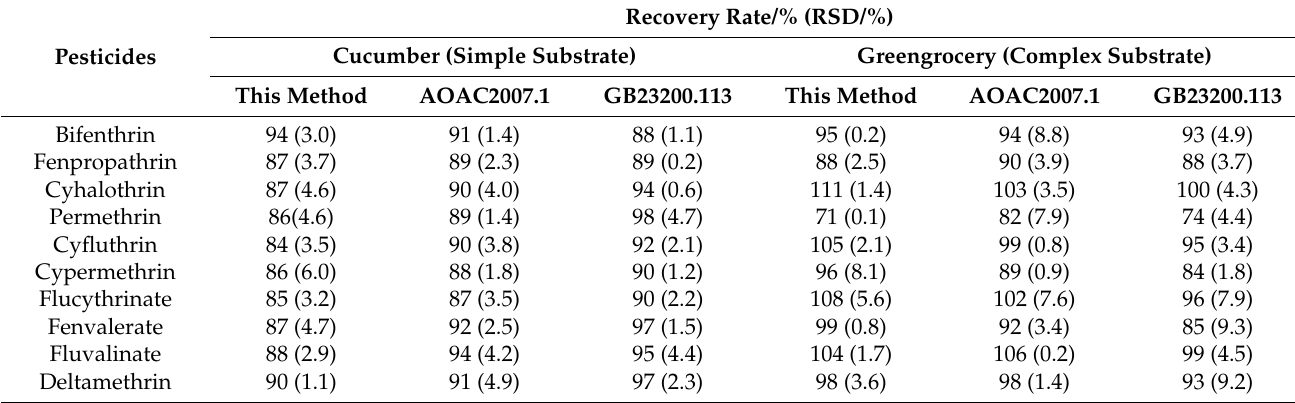
Table 4. Comparison with AOAC2007.1 and